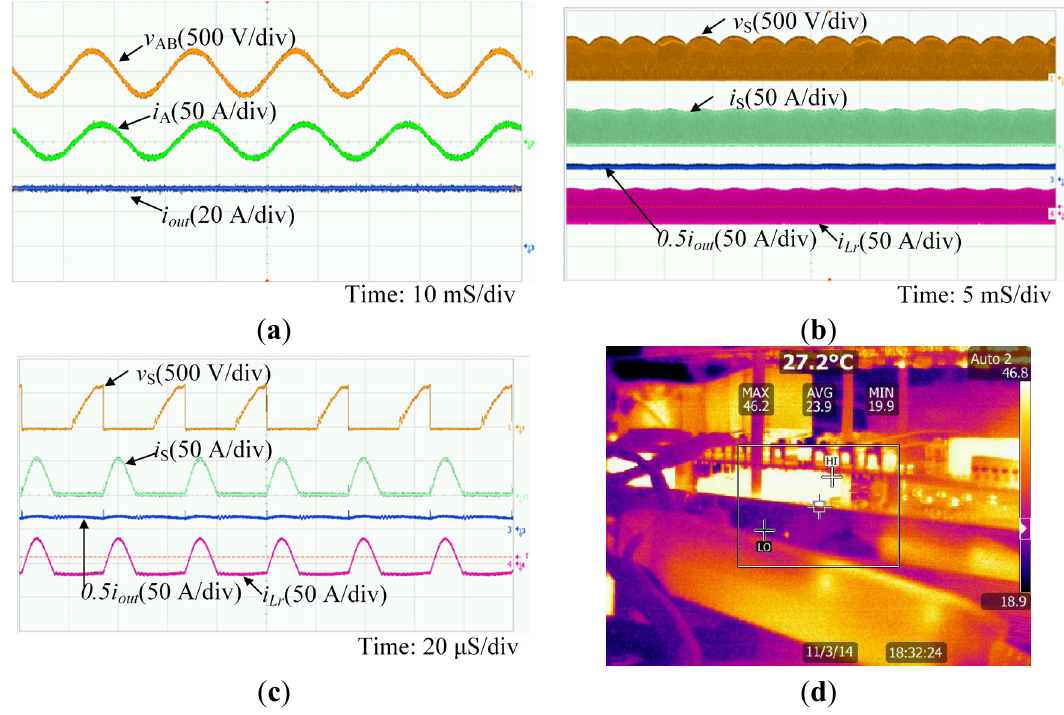
Figure 20. Experimental results (230-V input line voltage, 200-V output, 6-Ohm load resistance): ( a ) input voltage, input and output current; ( b ) envelop of resonant voltage and current; ( c ) enlarged waveform of resonant voltage and current; ( d ) thermal image.